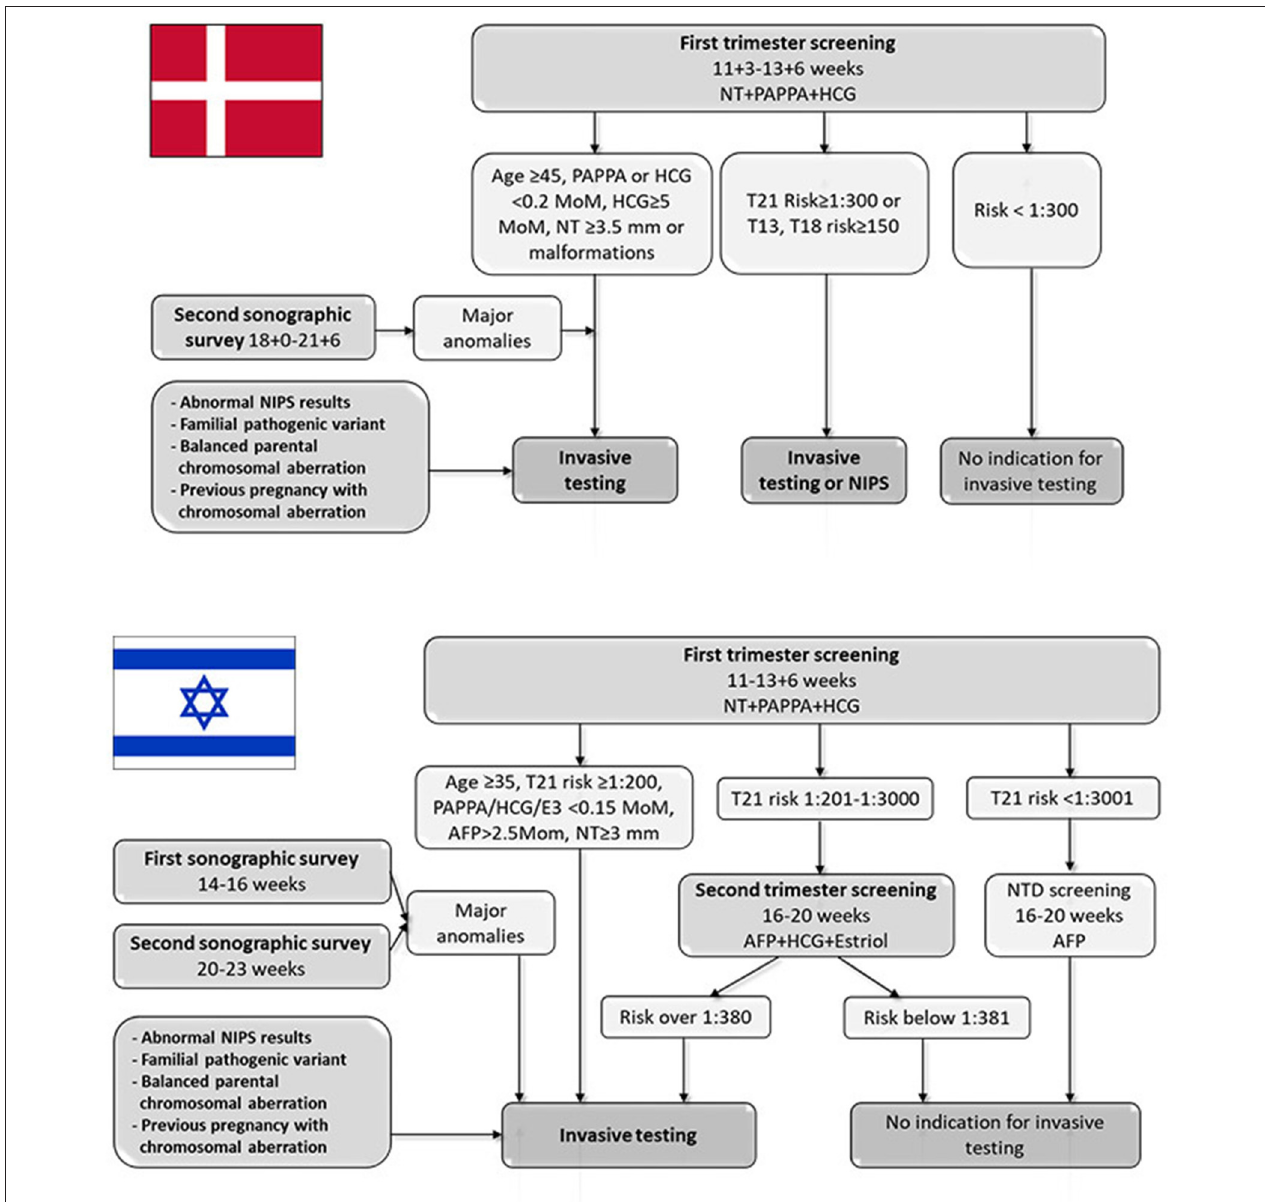
FIGURE 1 | Danish and Israeli algorithms of national screening program for identifying pregnancies at risk for chromosomal aberrations. AFP, Alpha-fetoprotein; HCG, human chorionic gonadotrophin; NIPS, non-invasive prenatal screening; NT, nuchal translucency; NTD, neural tube defects; PAPPA, Pregnancy-associated plasma protein